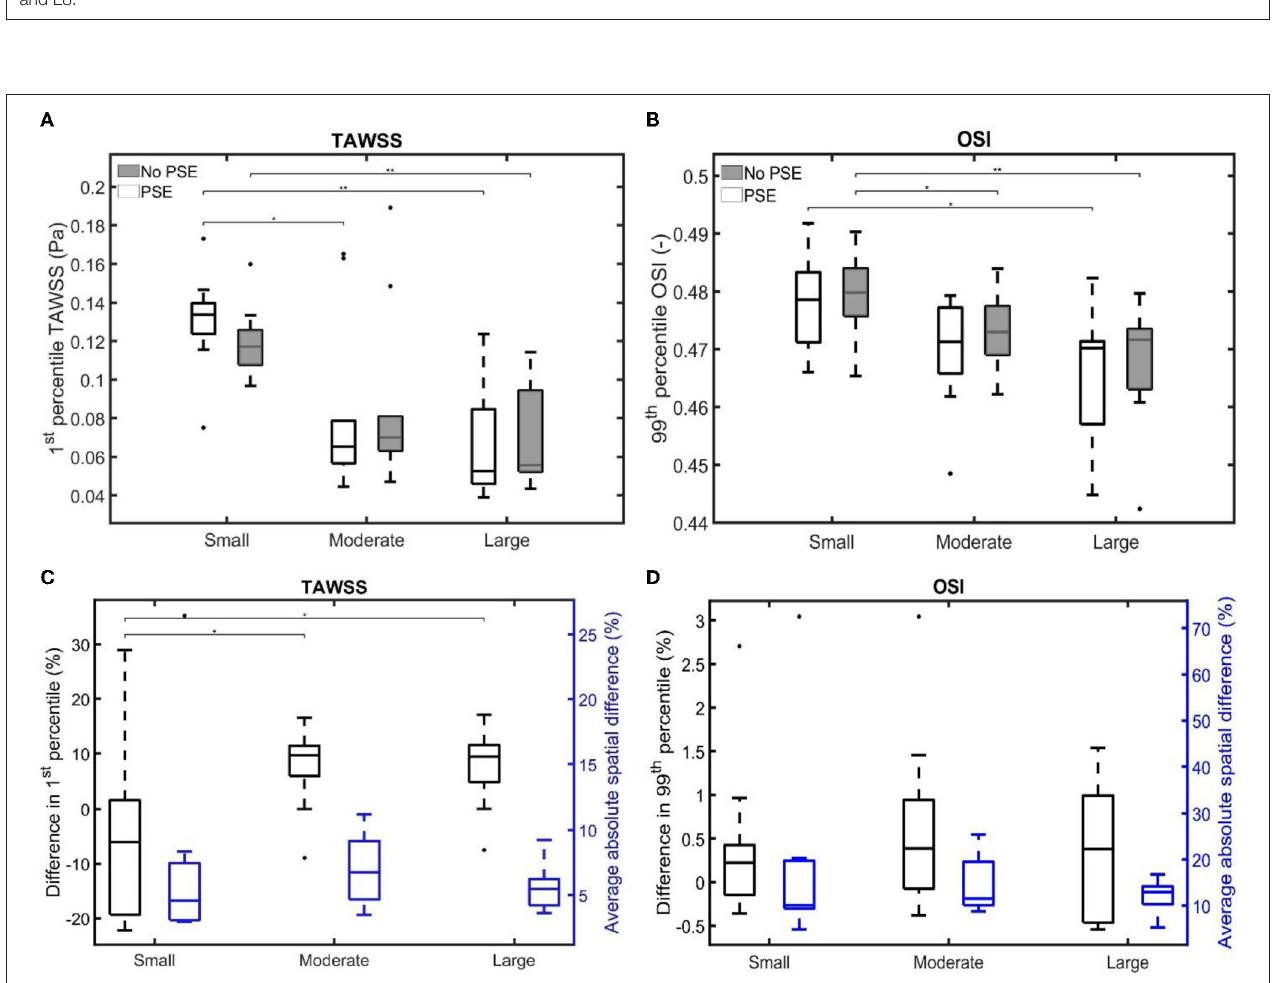
FIGURE 11 | Visualization of (A) the 1st percentile TAWSS and (B) the 99th percentile OSI for both FSI simulations for the different patient groups. (C,D) Visualize the difference in 1st/99th percentile (black) and average absolute spatial difference (blue) between the FSI simulations for the TAWSS and OSI, respectively. Significant differences between groups are indicated with bars and stars ( ∗∗ p ≤ 1e-2, ∗ p ≤ 0.05).